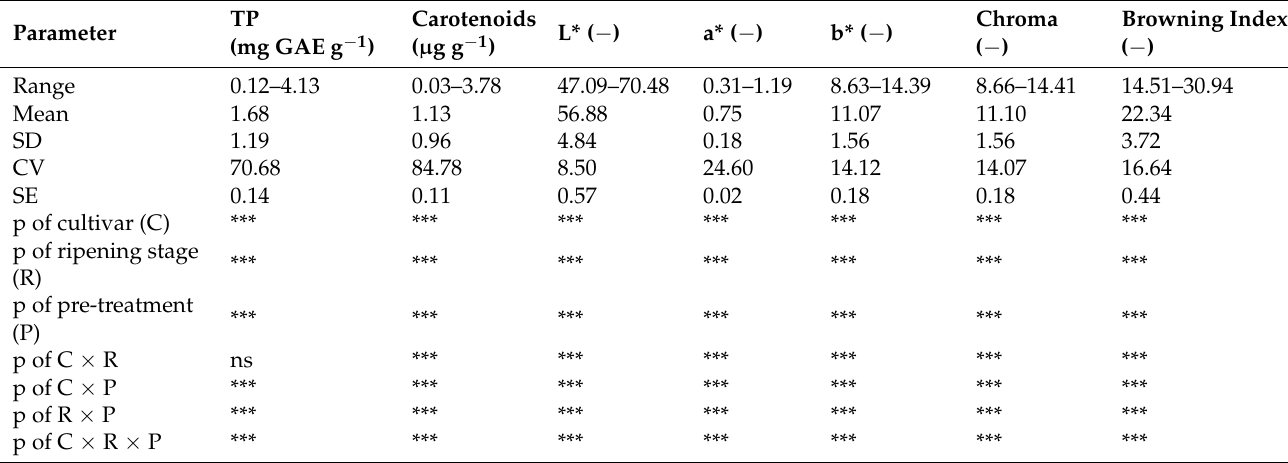
Table 3. ANOVA statistics showing the effect of cultivar, ripening stages, and pre-treatment methods on the total phenolic, carotenoid contents, and color alterations of plantain flours.